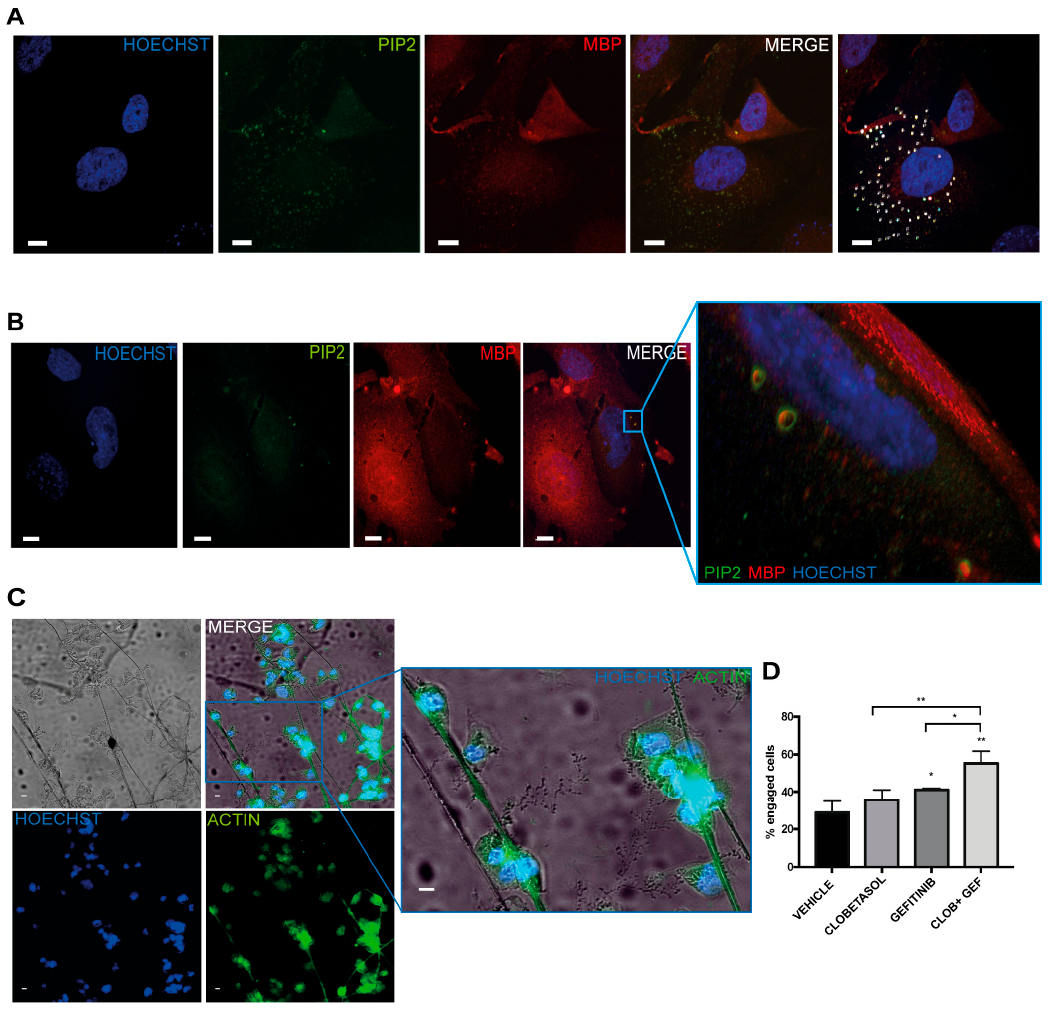
Figure 5 . Clobetasol and Gefitinib co-treatment triggers MBP and PIP2 co-localization and enhances Oli-neuM engagement of polystyrene microfibers. ( A , B ) Confocal microscopy images of Oli-neuM cells treated with 5 µ M Clobetasol and 1 µ M Gefitinib, stained with α -MBP (TRITC) and α -PIP2 (FITC). Nuclei (Hoechst). ( A ) Immunofluorescence images of cells showing PIP2 and MBP co-localization. Co-localization measurement details are shown in Figure S3. In the right-most panel, the co-localizing spots are highlighted by white dots. ( B ) Co-localization of MBP-PIP2. Colocalization analyses are in Figure S2. Confocal images of cells in which three-dimensional (3D) reconstruction has been performed. The blue boxed area in the MERGE panel indicates the region containing the co-localizing spots that is enlarged in the right panel. Blue boxed right panel: 3D volume reconstruction was performed using Imaris 6.21 suite on cropped images (Z-stack = 0.3 µ m step size). Scale bar = 10 µ m. ( C ) Epifluorescence IF microscopy images of Oli-neuM cells grown on PS microfiber chambers. Representative IF images of Oli-neuM cells treated for 72 h with 5 µ M Clobetasol and 1 µ M Gefitinib (CLOB GEF) cultured on supports containing electrospun PS microfibers (2–4 µ m). Blue box shows an enlarged view of the region containing engaged cells. Cells were fixed and processed for IF microscopy as indicated in Materials and Methods. Fibers were visualized using phase contrast. Anti-actin (FITC), nuclei (HOECHST). Image acquisition was performed using a 20 × objective, as indicated in Materials and Methods. Scale bar: 10 µ m. ( D ) Engagement quantification after treatments. Image quantification was performed by analyzing 75 images / sample for each treatment (n = 3). Specifically, the percentage of engaged cells was estimated by counting nuclei located on fibers or within a range of 86 µ m from the fiber. Data were plotted in the graph (n = 3, mean ± SEM) using GraphPad Prism as indicated in the text. Two-tailed paired Student’s t test was used for statistical significance versus vehicle (NT), one-way ANOVA with Tukey’s multiple comparison test was used to analyze statistical significance among di ff erent treatments. * p < 0.05, ** p <